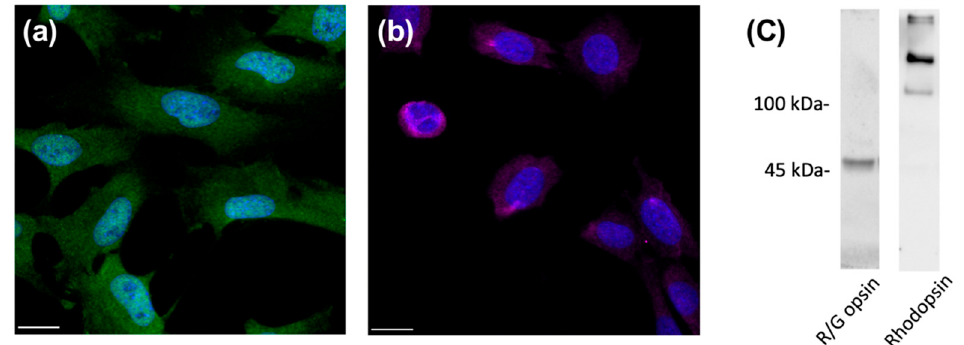
Figure 1. Expression of photoreceptor-specific markers in 661w cells. Immunocytochemical staining of 661w cells for ( a ) red/green opsin (green) and ( b ) rhodopsin (violet). DAPI (blue) was used to counterstain the nuclei. Scale bar: 20 µ m. Immunoblot analysis ( c ) was used to confirm the expression of red/green opsin (~48 kDa) and rhodopsin (oligomeric form, >100 kDa) in 661W